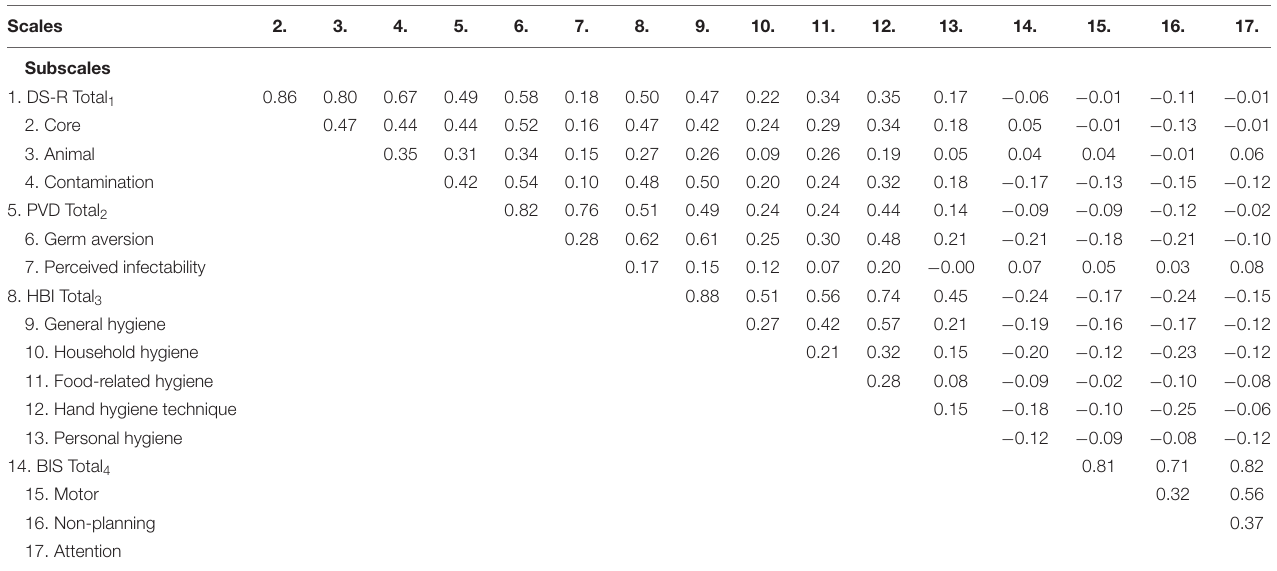
TABLE 2 | Correlation (Pearson’s) between the main measure totals and scale scores (5% critical alpha = ± 0.11) for the current dataset.